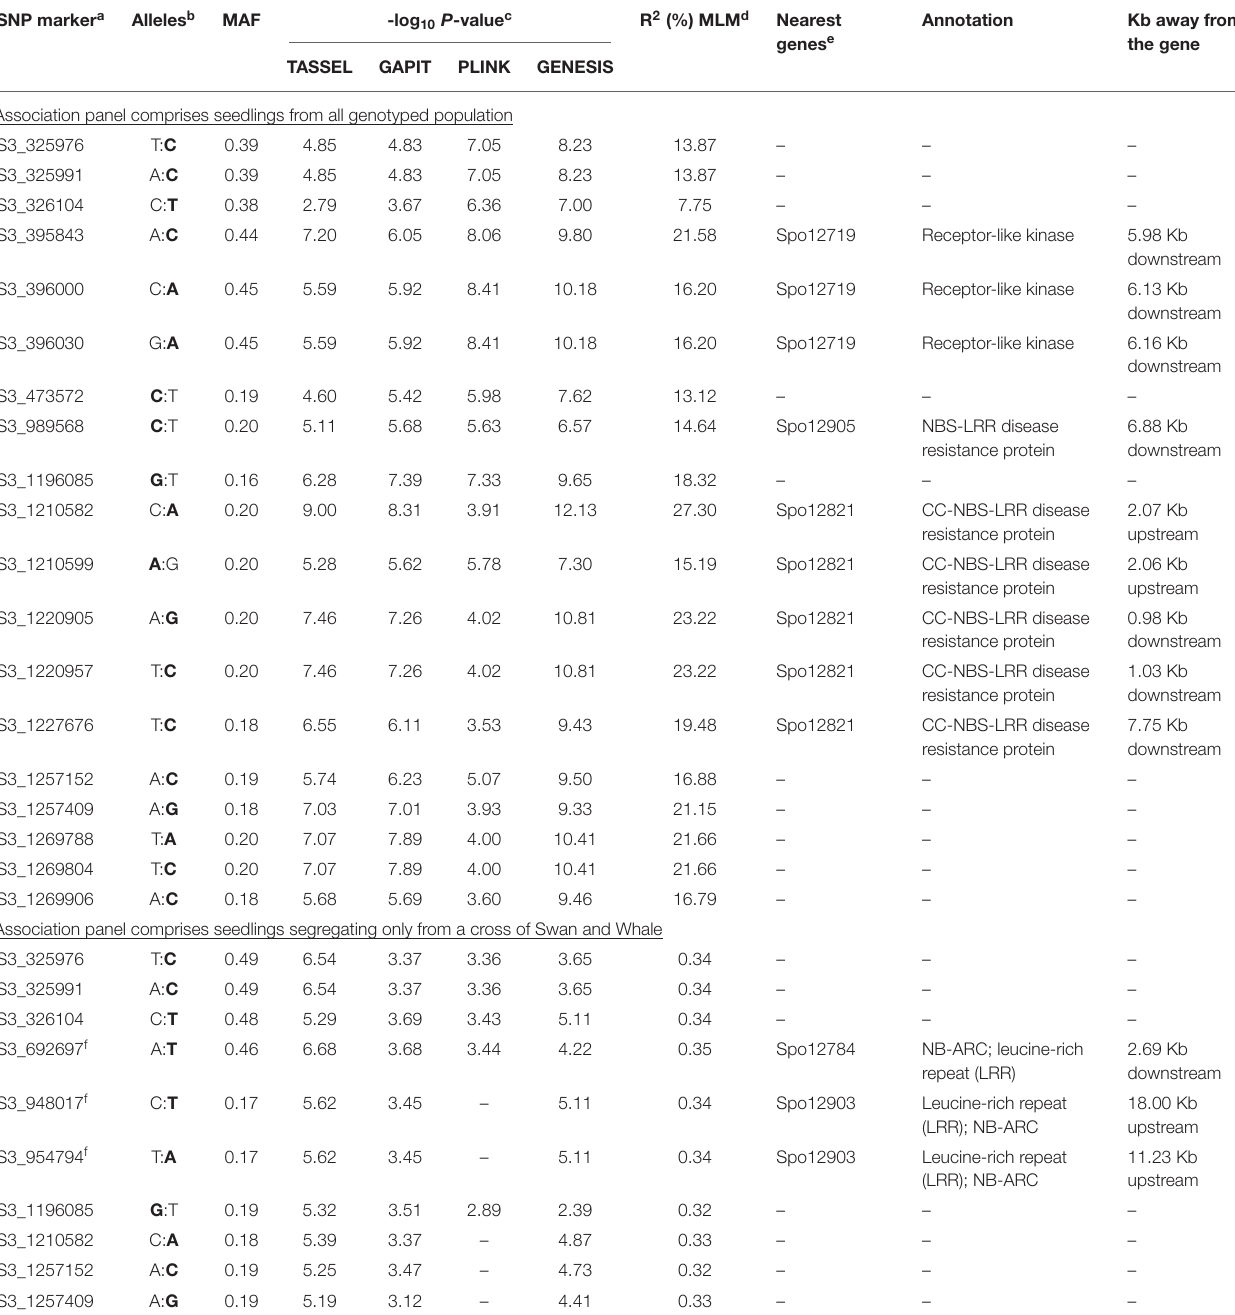
TABLE 2 | SNP markers associated with resistance to race 13 of P. effusa in spinach breeding populations. Progeny population was generated from a cross of resistant cultivars Swan, squirrel, Tonga, T-Bird with susceptible cultivars Whale and Polka. SNP marker a Alleles b